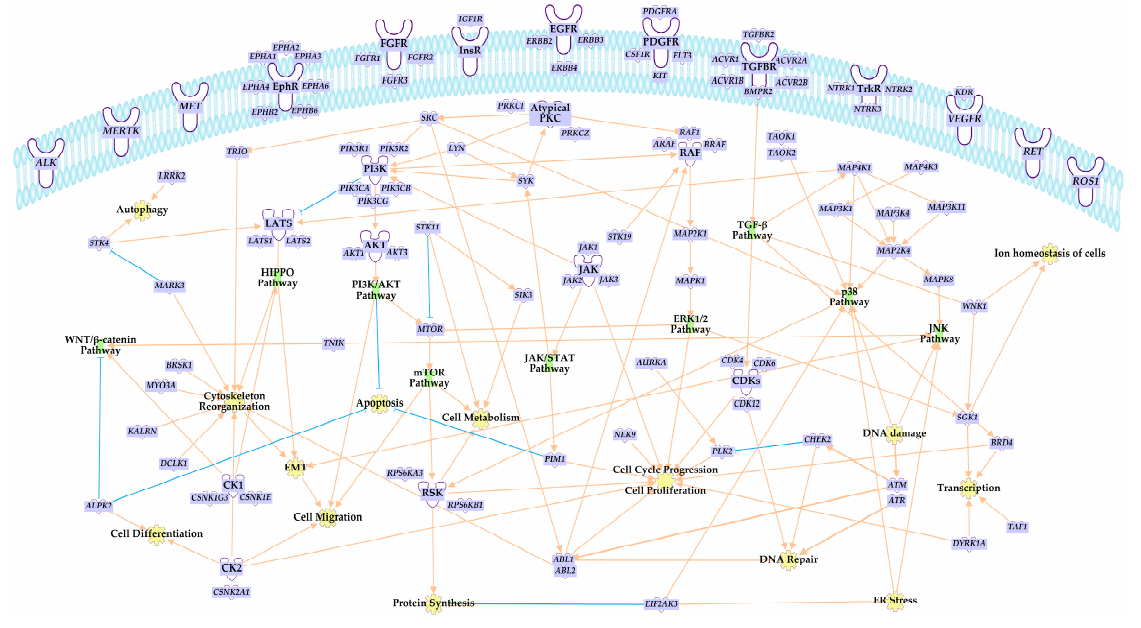
Figure 2. Drivers of cancer development within cellular kinome. The scheme represents established genes coding for protein kinases and their intracellular signaling roles, disruption of which is involved in chronic disease. The figure was compiled using information provided in the literature [9,17,22–24,27] as well as QIAGEN Ingenuity Pathway Analysis Knowledge Base. On the plasma membrane (top), there are tyrosine kinase and tyrosine kinase-like receptors, the activation of which initiates various signaling cascades depicted inside the cell. For simplification, only the driver genes are included in the figure; the relationship arrow lines indicate activation/causation (in light orange) or inhibition/suppression (in light blue); only the most prominent intracellular signaling pathways (in green) and cellular events associated with respective kinases (in yellow) are depicted. ABL1: ABL proto-oncogene 1, non-receptor tyrosine kinase; ABL2: ABL proto-oncogene 2, non-receptor tyrosine kinase; ACVR1: activin A receptor type 1; ACVR1B: activin A receptor type 1B; ACVR2A: activin A receptor type 2A; ACVR2B: activin A receptor type 2B; AKT1: AKT serine/threonine kinase 1; AKT3: AKT serine/threonine kinase 3; ALK: ALK receptor tyrosine kinase; ALPK2: alpha kinase 2; ARAF: A-Raf proto-oncogene, serine/threonine kinase; ATM: ATM serine/threonine kinase; ATR: ATR serine/threonine kinase; AURKA: aurora kinase A; BMPR2: bone morphogenetic protein receptor type 2; BRAF: B-Raf proto-oncogene, serine/threonine kinase;